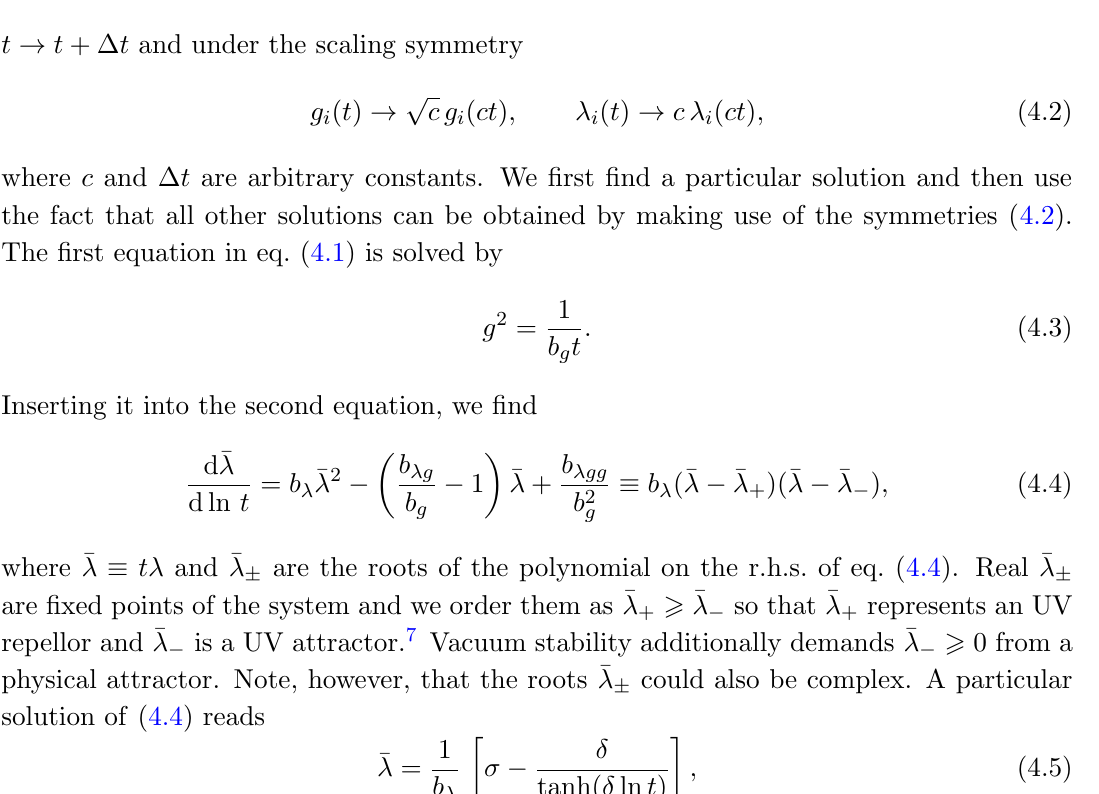
Figure 2 . Projections of the four-dimensional orbit space of the representation 15